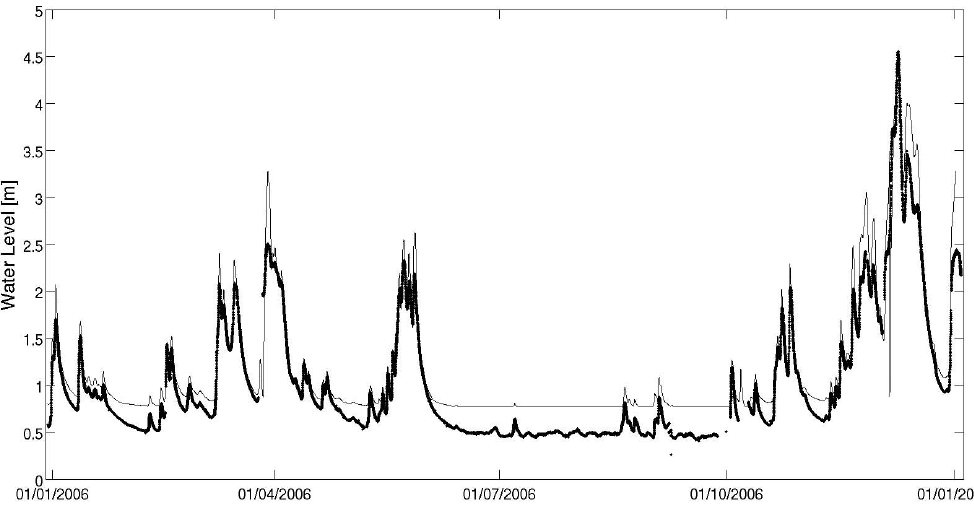
Fig. 2. Summary plots of the data available for Welsh bridge during the calibration period. Points represent observed data with the line being the concatenation of the output of the most recent hydraulic model initialisation. A bias in the prediction of low flows is clearly shown as are periods of missing data and poor model